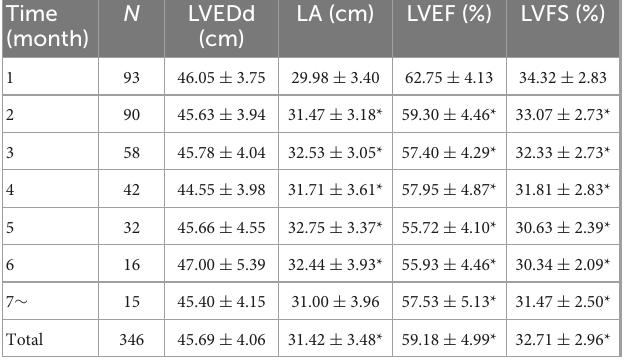
average onset time of 89.3 and 49.5 days, respectively. The elevation of NT-proBNP occurred more frequently in the first 10 weeks, while CTRCD and the elevation of cTnT occurred continuously during the follow-up period after receiving ICI, with an average onset time of 102 and 75.4 days, respectively ( Figure 6